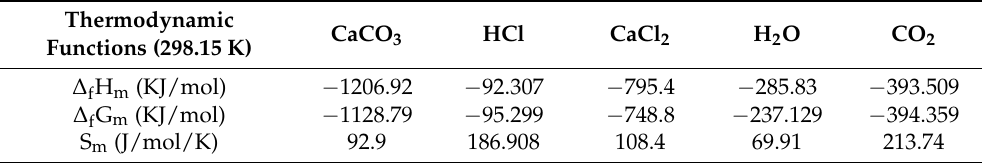
Table 6. Thermodynamic functions data of reaction (11).